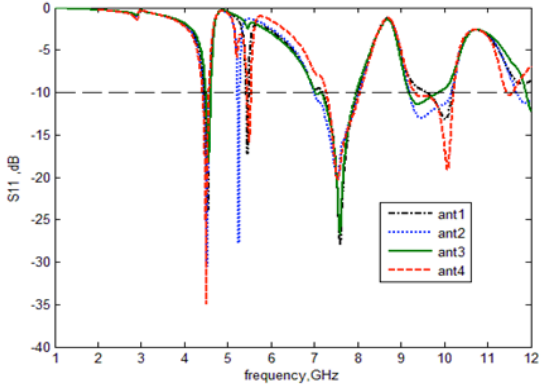
Figure 5. Input re fl ection coefficients for various antennas involved.